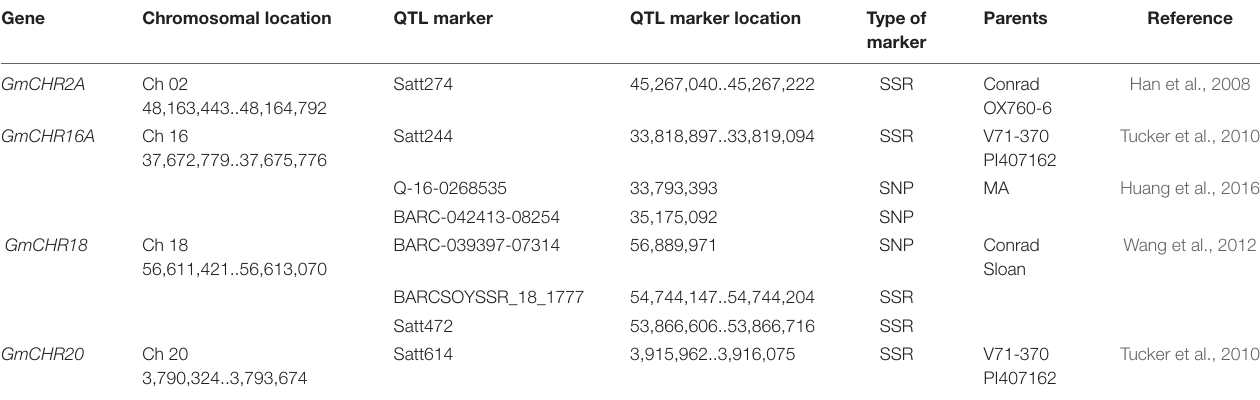
TABLE 4 | Characteristics of QTL markers linked to P. sojae resistance that flank GmCHRs. Gene Chromosomal location QTL marker